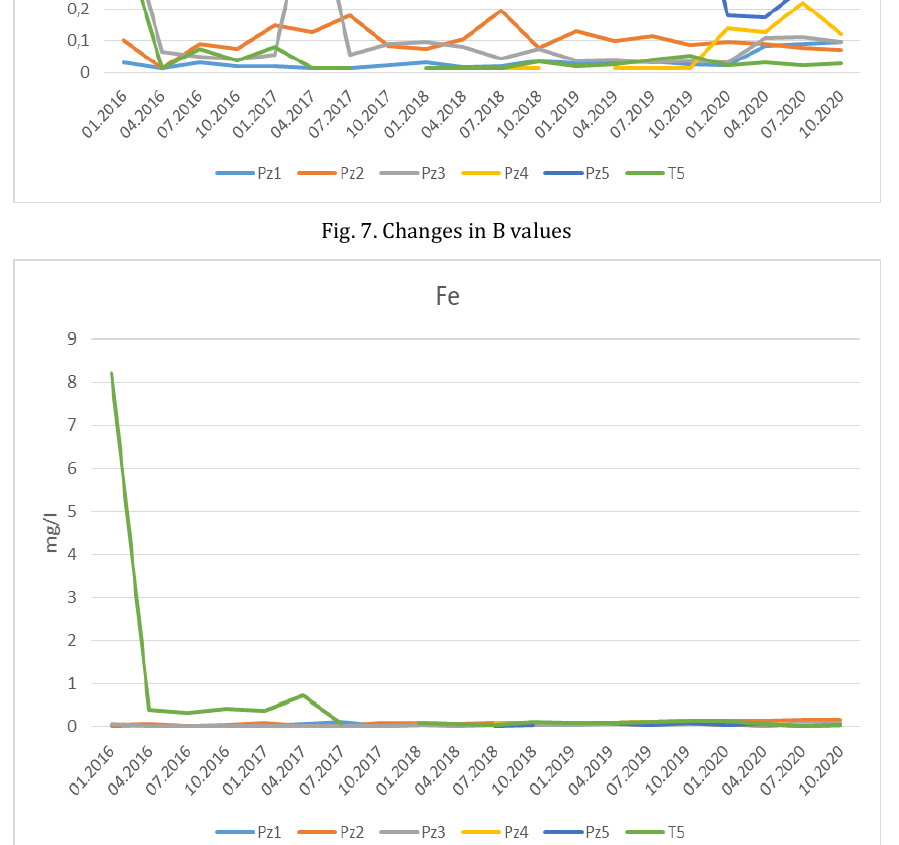
Fig. 6. Changes in SO 42- values